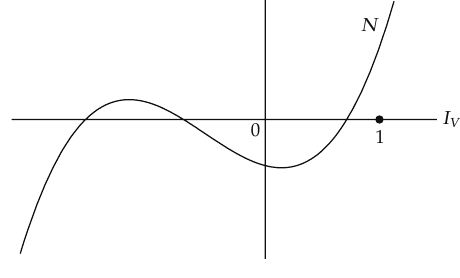
Figure 4: Graph of the polynomial N .